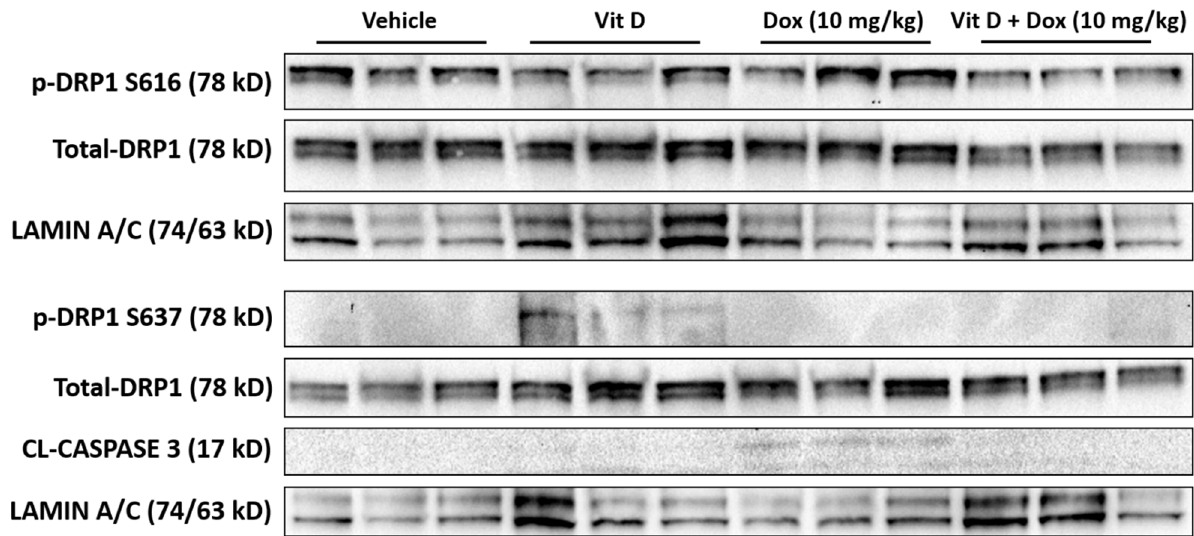
Figure 6. Immunoblot for dynamin-related protein 1 (DRP1) phosphorylation in mouse cardiac tissue. Phosphorylated DRP1 (p-DRP1) serine 616 (S616) was increased with Dox (10 mg/kg) but decreased with vitamin D + Dox (10 mg/kg); p-DRP1 serine 637 (S637) was increased with vitamin D but not with Dox (10 mg/kg). Cleaved Caspase 3 (CL-CASPASE 3), a marker for mitochondrial damage, was increased with Dox (10 mg/kg). Total DRP1 was included as a control, and LAMIN A/C was the loading control. Each lane represents the results for one mouse; three mice per experimental group were analyzed.